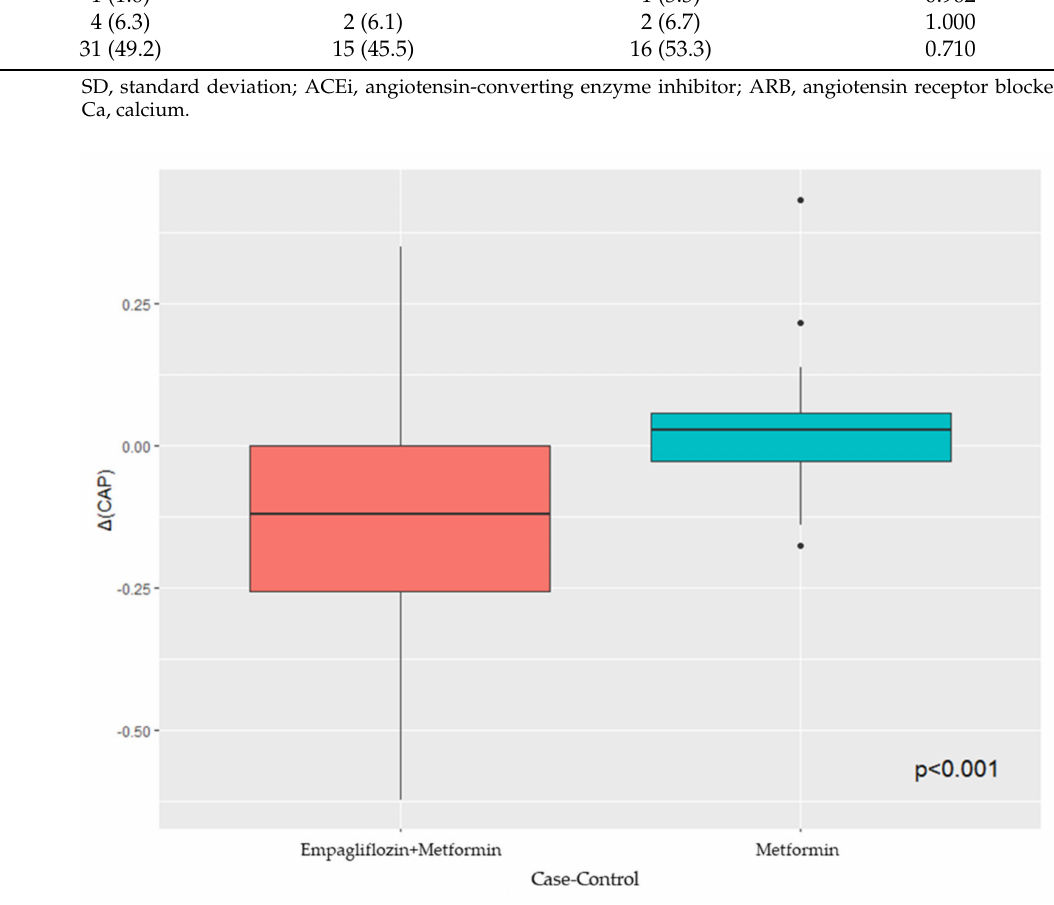
Figure 1. Box plot analysis of CAP variation in case and control groups. Of note, no adverse events were reported by our patients during the observation